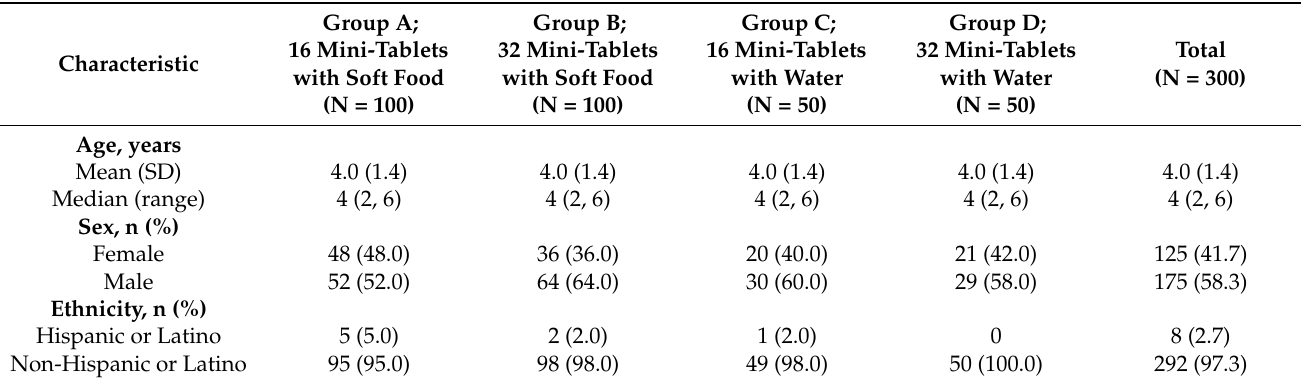
Table 1. Demographic characteristics of study